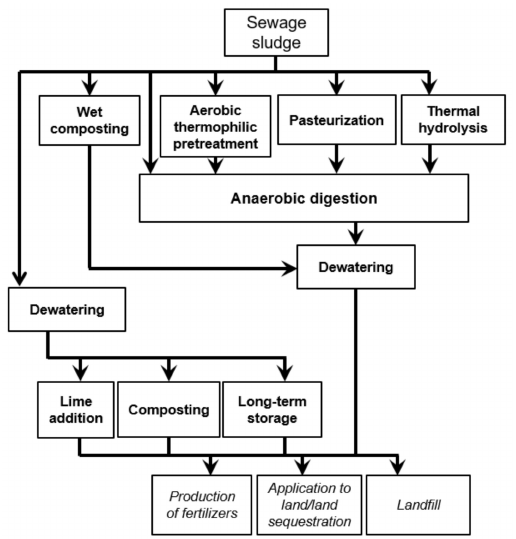
Figure 3. Sludge management practices in Norway (adapted from [51]). The treatment methods are in bold, while disposal methods are in